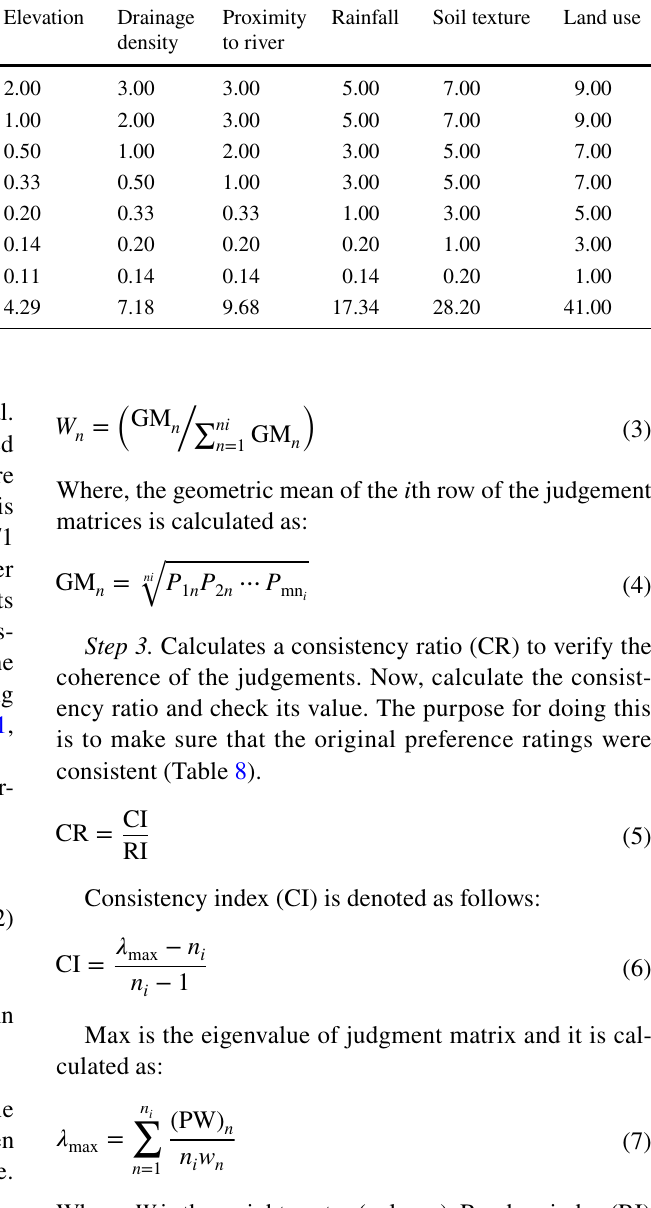
matrix calculated